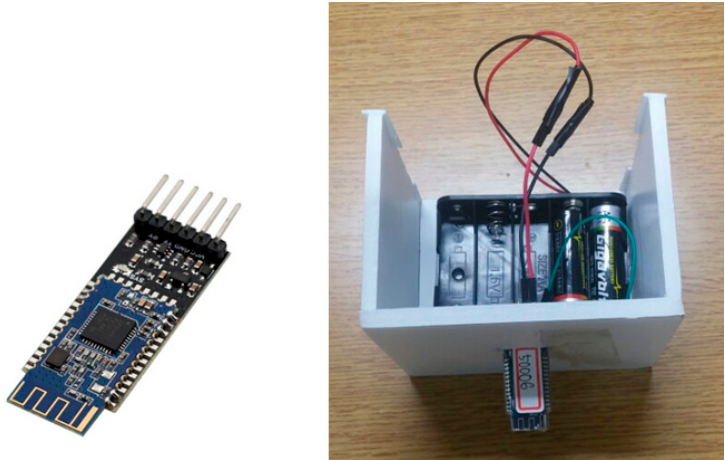
Figure 13. Bluetooth Module (HM-10) and Location Beacon Experiment Tool (Using Scenario 1).